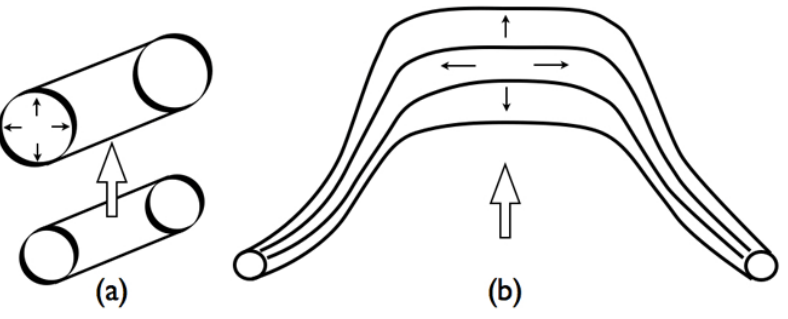
Figure 10: Two different scenarios considered for deriving the scaling relation between density and magnetic field strength in Section 3.2.1. Panel (a) illustrates the case where a horizontal flux tube rises uniformly and expands only in the directions perpendicular to the tube axis. Panel (b) shows a scenario where a localized segment of a flux tube rises and expands (‘magnetic bubble’ case). Due to the diminishing scale heights near the surface, it has a flattened structure (cf. Figures 7 and